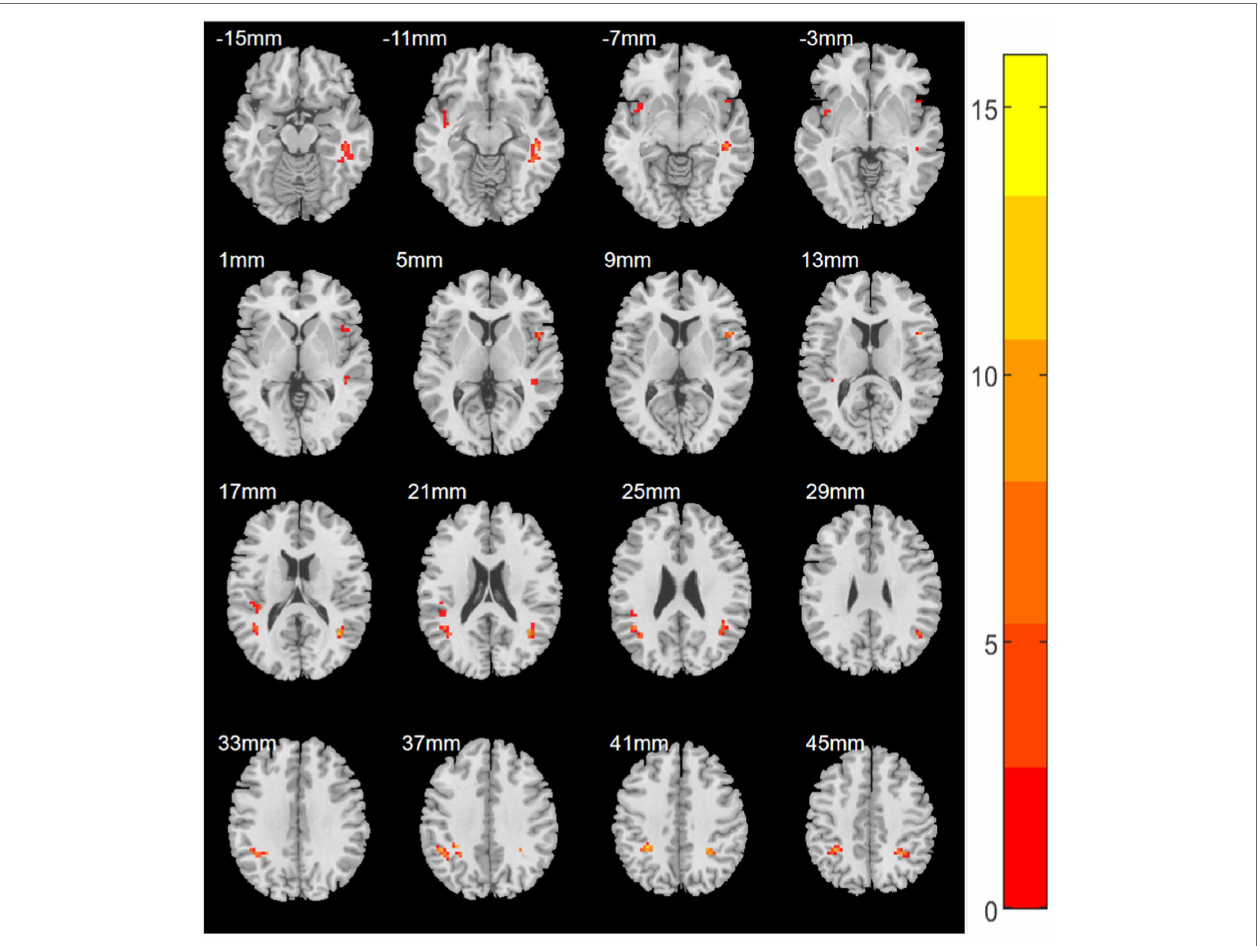
FIGURE 1 | Statistical maps showing ANOVA results for ReHo abnormalities between EORD or LORD patients and HCs (GRF corrected). Color bar indicates red to yellow showing enhancement of ReHo